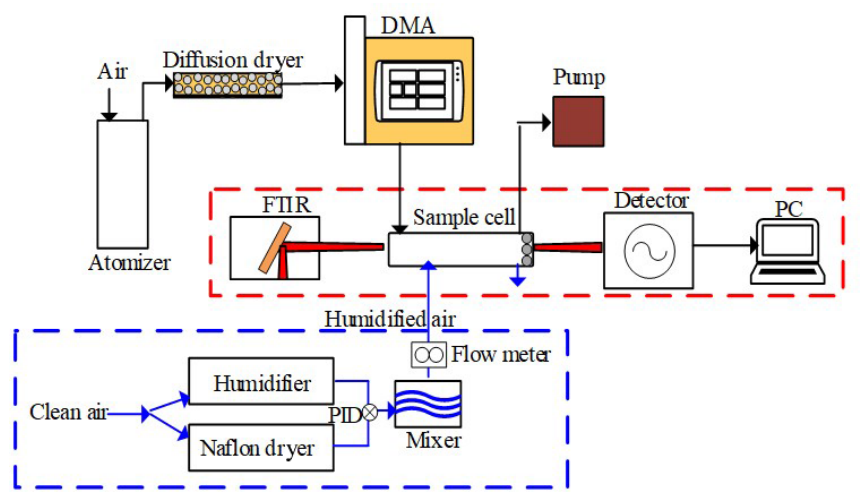
Figure 1. Diagrammatic sketches of the experimental system used to measure nanoparticle hygroscopicity. The dashed red box represents the FTIR system, and the dashed blue box represents the humidification system (DMA: differential mobility analyzer; PID: proportional integral differential control). Table 1. The density, solubility, and molecular mass of all chemical compounds used in this study. Chemical compound Molecular mass